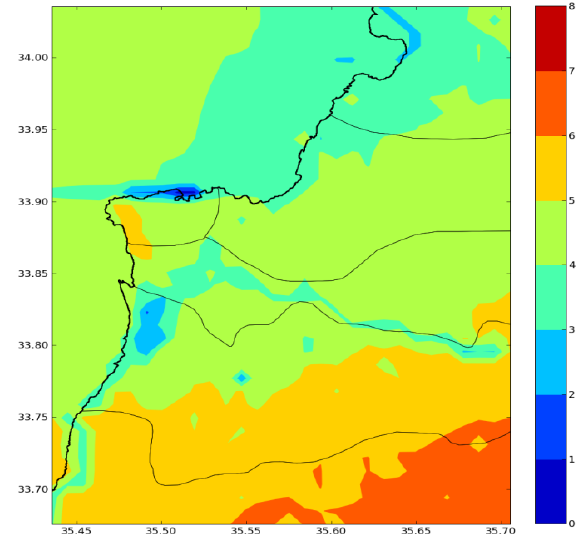
Figure 5. Modeled average VOC/NO